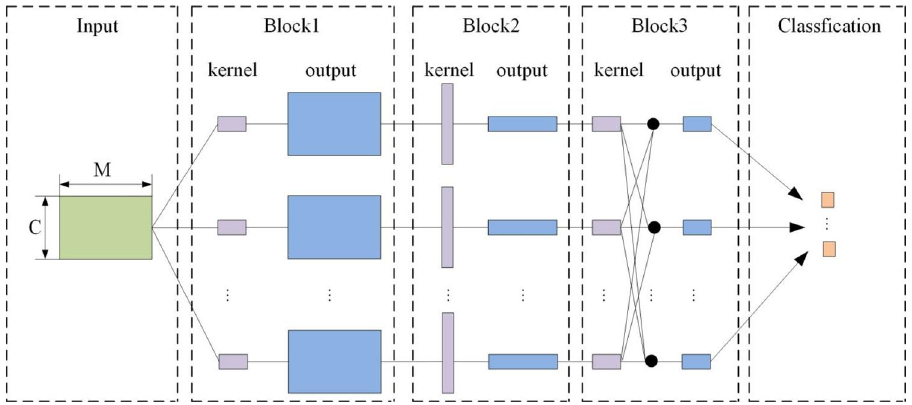
Figure 2. The overall visualization of the EEGNet structure. The line represents the connectivity of the convolution kernel between input and output (called feature map). Where, C is the number of channels, T is the number of sampling points.